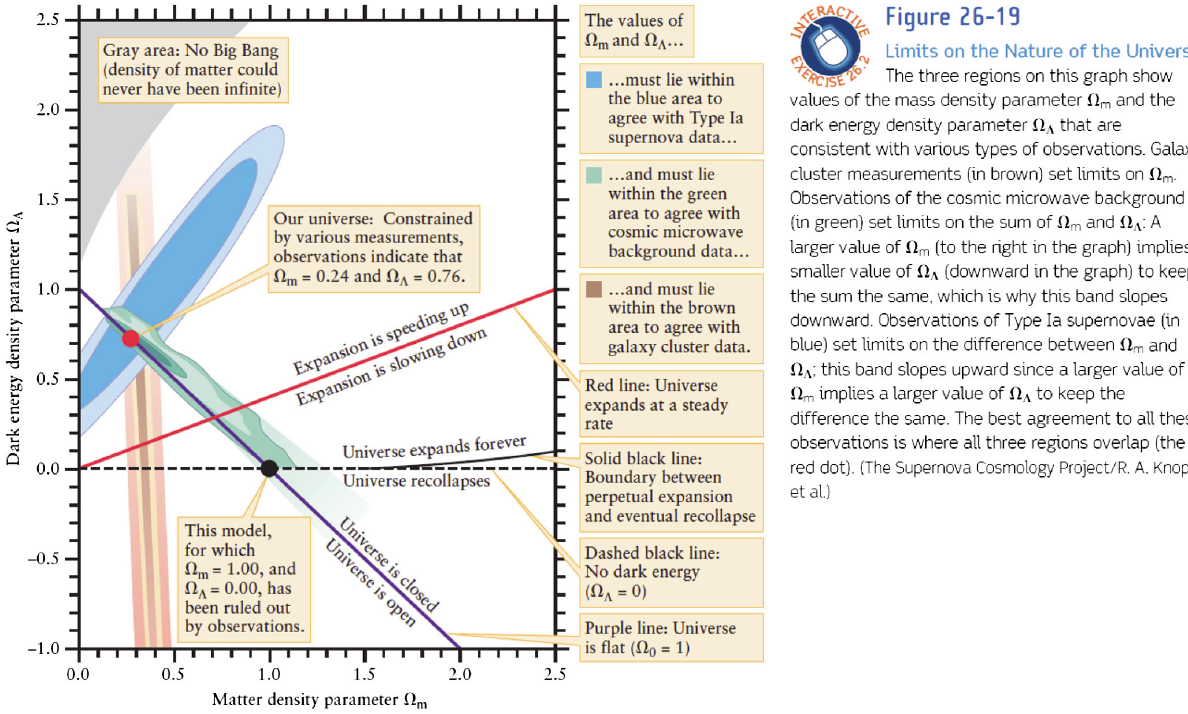
FIG. 28. Modified figure used in an introductory astronomy textbook. Image credit: Freedman, Geller, and Kaufmann [101]. Used with permission.